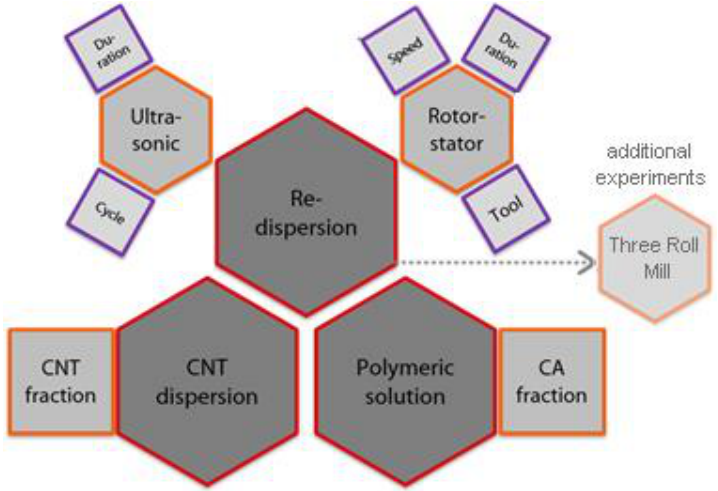
Figure 5. Summary of analyzed influencing factors in the parametric study of main dispersion step.